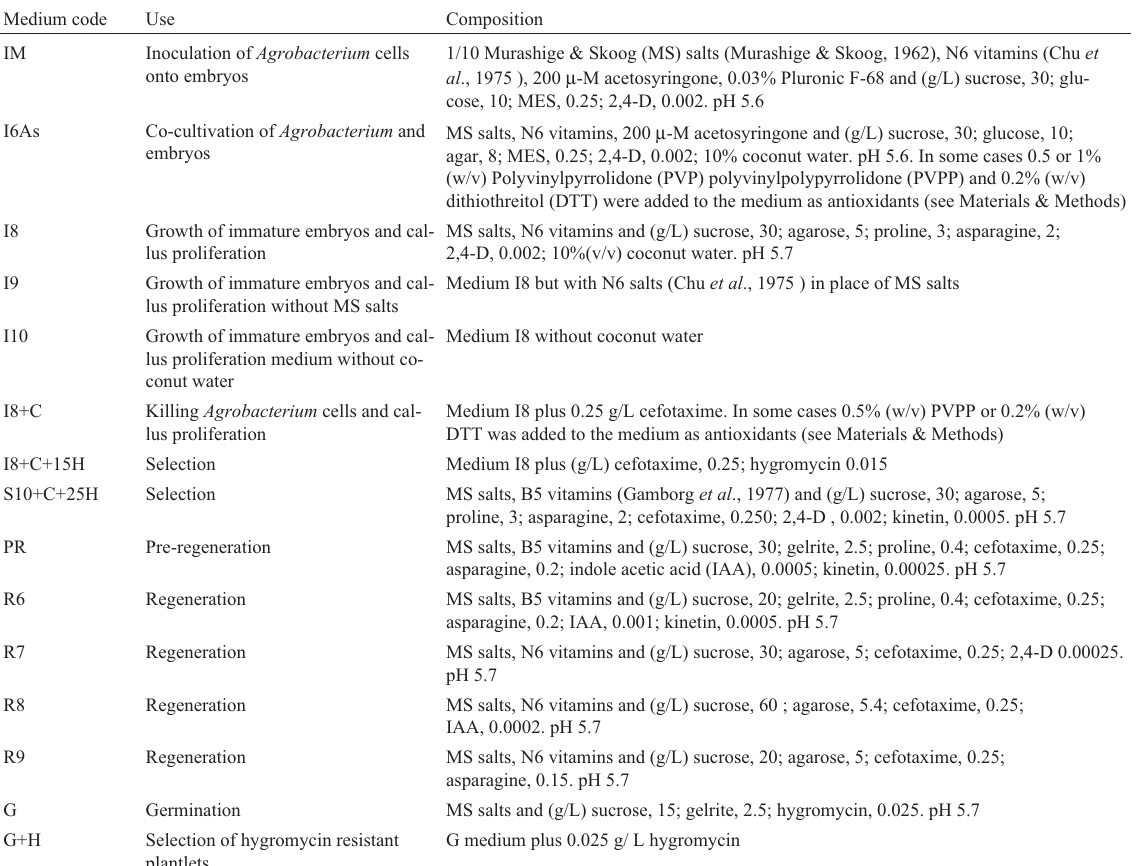
Table 1 - Media used for tissue culture and transformation. Media components were autoclaved together at 121 °C for 20 min , coconut water and antibiotics being added after autoclaving. Medium